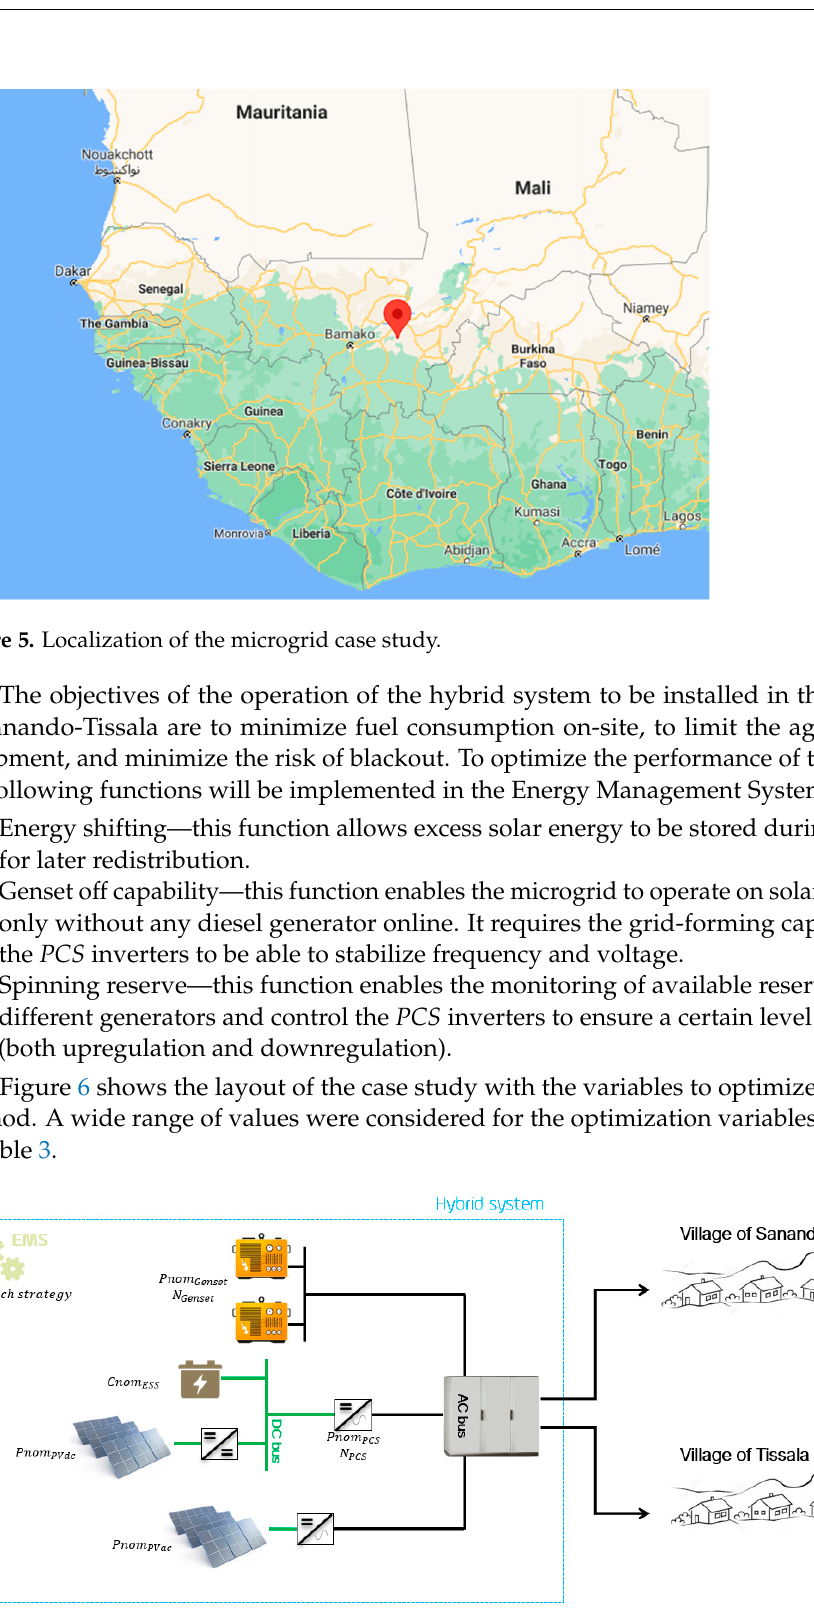
Figure 6. Schematic of the case study.